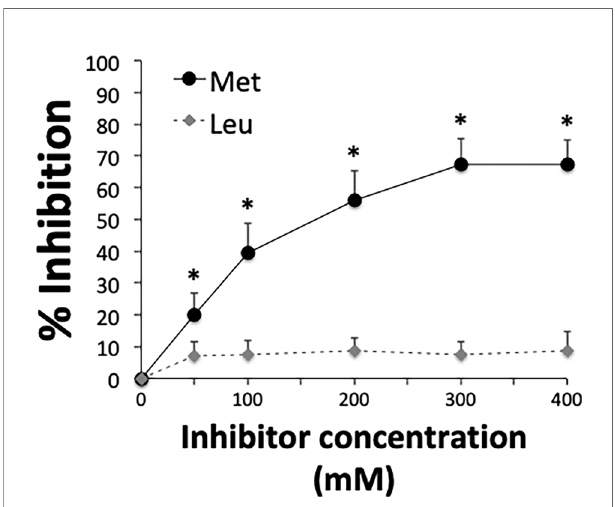
FIGURE 5 | Free L-methionine inhibits interactions between Plg and the MK- rich domain. Selective inhibition of the interactions between Plg and the rMut4 fragment that lacks all of the lysine residues present in the MK-rich fragment. Competitive ELISA assays were done with immobilized rMut4 fragment (250 nM) to which Plg (100 nM) was added in the presence of increasing concentrations of L-methionine (Met). L-leucine (Leu) was used as a negative control. Inhibition ability is shown as percentage. Data are means ± SD from three independent experiments conducted in duplicate. *p < 0.05 as determined by Wilcoxon rank sum test